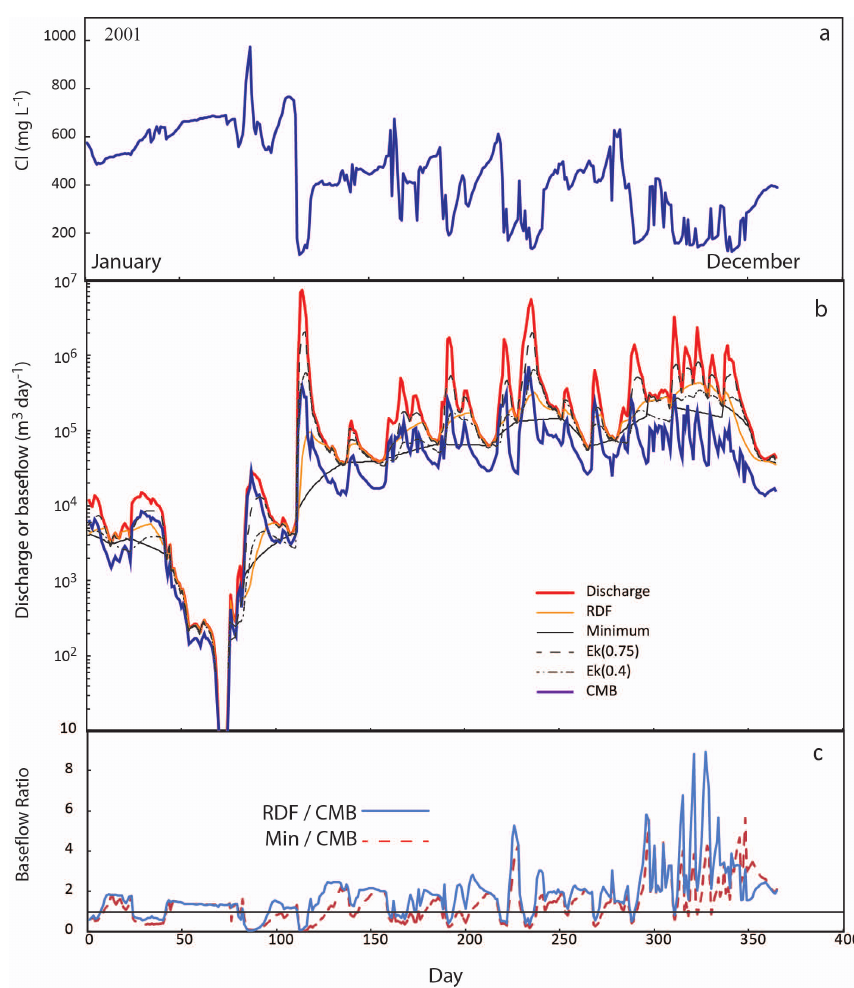
Fig. 3. (a) Variation in Cl concentrations in the upper Barwon River at Winchelsea in 2001. (b) Variation in discharge of the Barwon River at Winchelsea in 2001 and estimated baseflow calculated by the Nathan and McMahon (1990) implementation of the Lyne and Hollick (1979) digital filter (RDF), local minimum (Sloto and Crouse, 1996) (Min), the Ekchardt (2005) digital filter with BFI max =0.75 (Ek(0.75)) and 0.4 (Ek(0.4)), and chemical mass balance (CMB). (c) Ratio of baseflows derived by smoothed minimum and the Lyne and Hollock (1979) digital filter to that estimated by chemical mass balance. Days are from 1 January. Data from Water Resources Data Warehouse